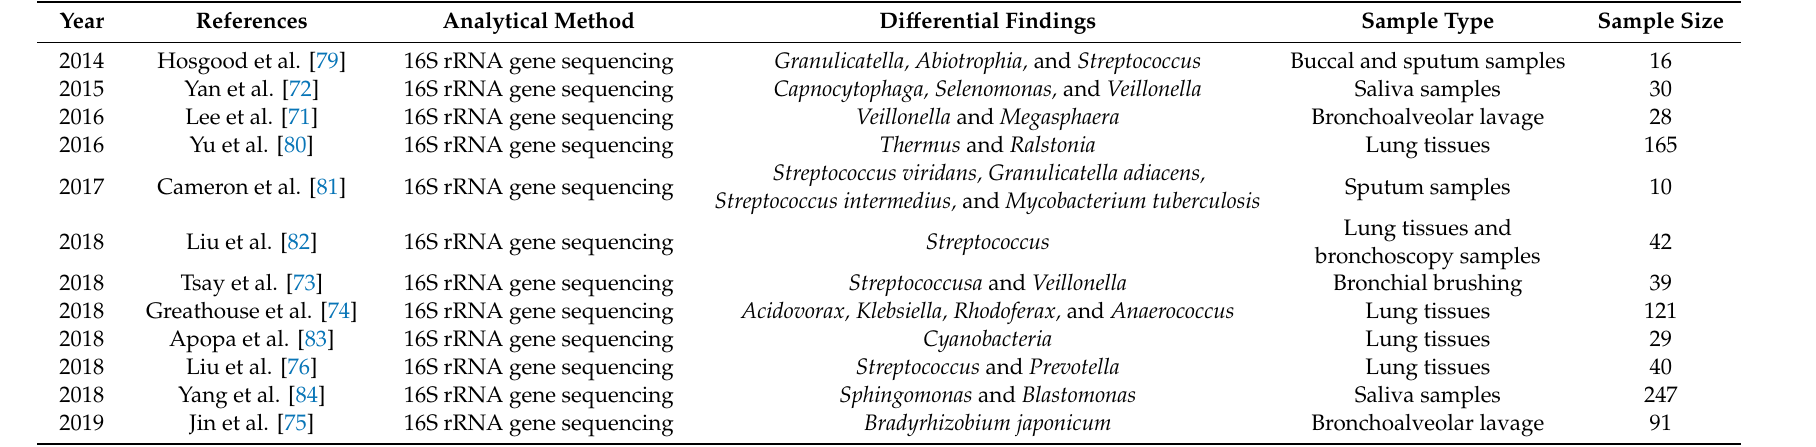
Table 3. Review of microbiota found in patients with lung